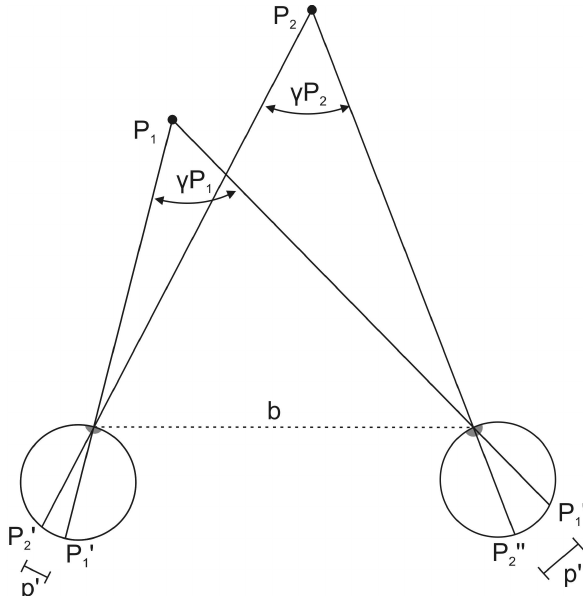
Figure 2. Principle of stereo viewing with a 3D camera: b = baseline, distance between the camera’s lenses; P1 and P2 = two points of an object; P1' and P2' = projections of P1 and P2 on the left lense; P1'' and P2'' = projections of P1 and P2 on the right lense; Ɣ P1 and Ɣ P2 = convergence angles; p''- p' = stereoscopic parallax (modified after Albertz,